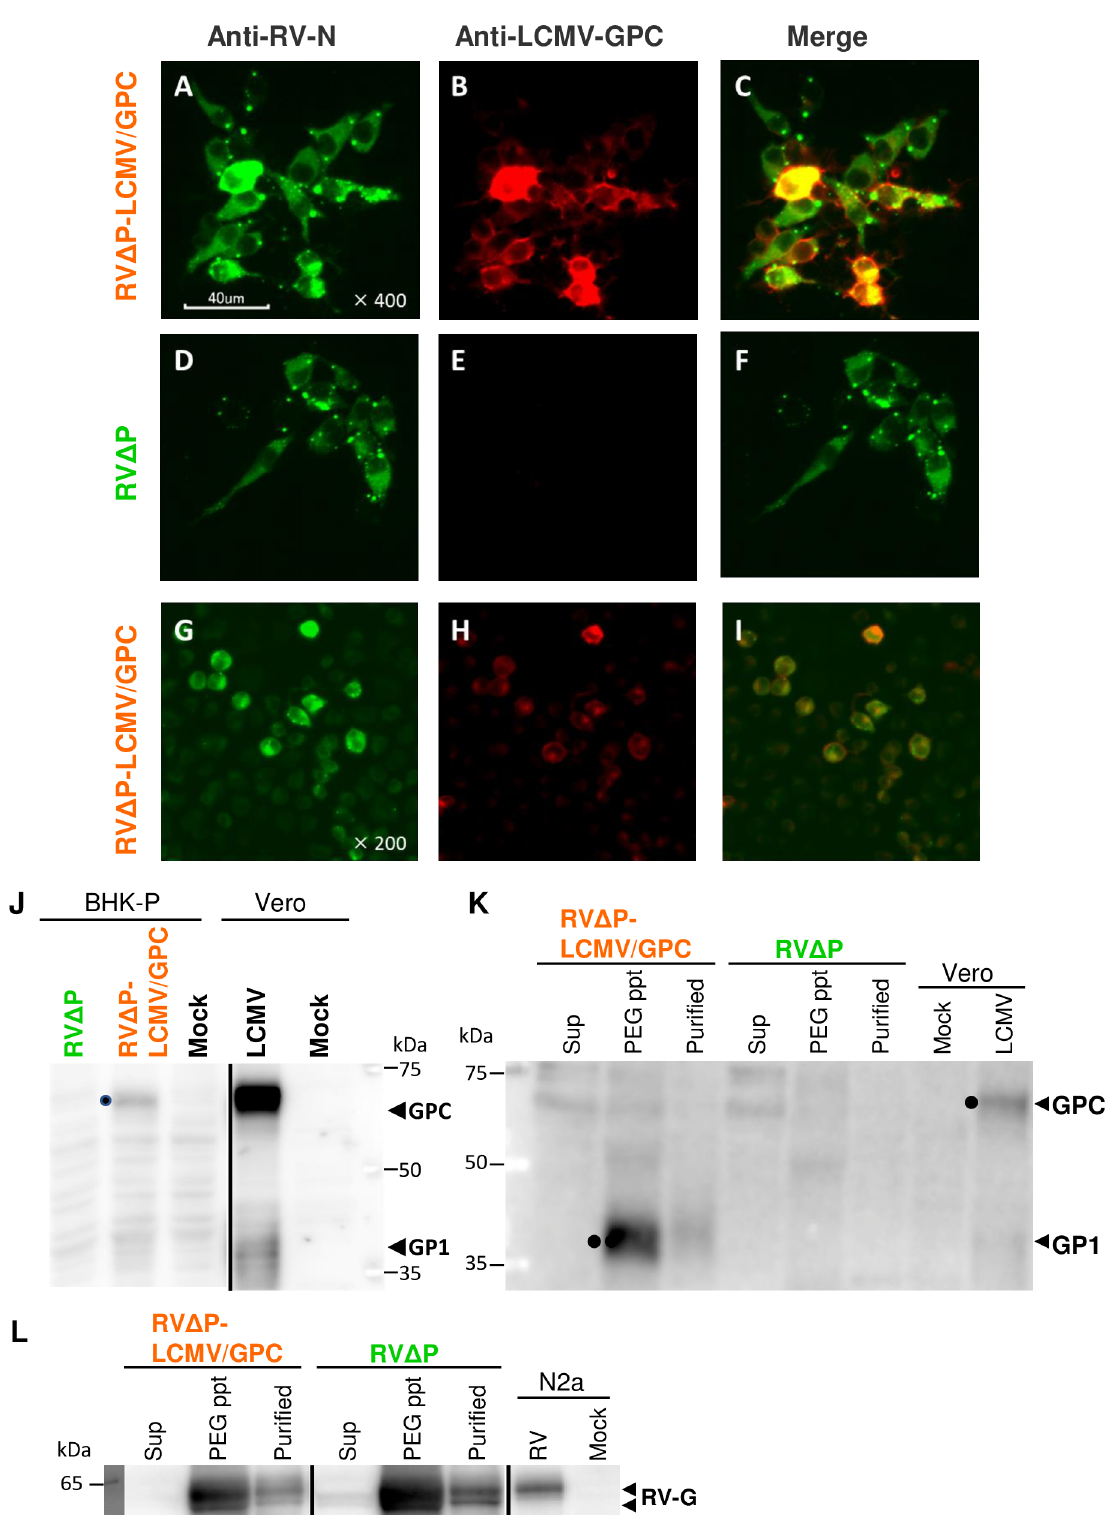
Fig 2. Confirmation of RV-N and LCMV-GP expression. BHK-P cells were inoculated with RV Δ P-LCMV/GPC (A–C) or RV Δ P (D–F) at an MOI of 0.1 and incubated at 33˚C for 48 h. Cells were stained with anti-RV N mAb or the anti-LCMV-GP1 mAb. Original magnification, 400×. (G–I) RV-N and the LCMV-GPC were detected in Neuro-2a cells inoculated with RV Δ P-LCMV/GPC at an MOI